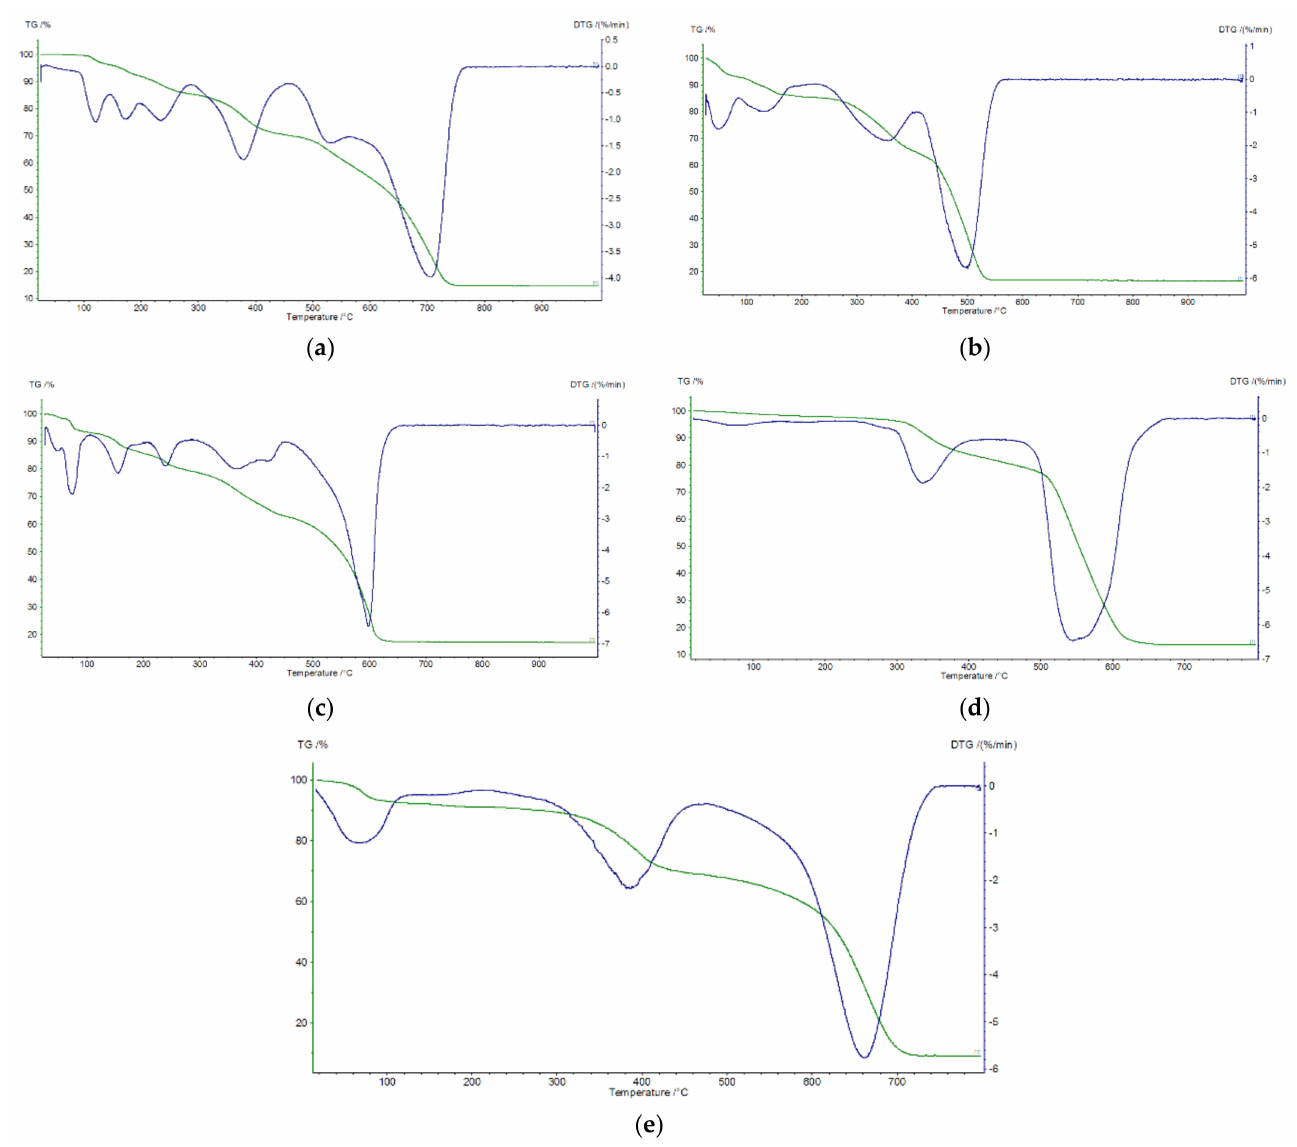
Figure 5. ( a ) TG/DTG curve of compound ( 1 ); ( b ) TG/DTG curve of compound ( 2 ); ( c ) TG/DTG curve of compound ( 3 ); ( d ) TG/DTG curve of compound ( 4 ); ( e ) TG/DTG curve of compound ( 5